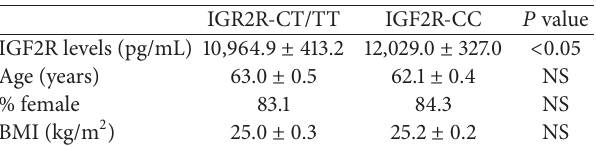
Table 4: The differences of variables between groups with and without the T